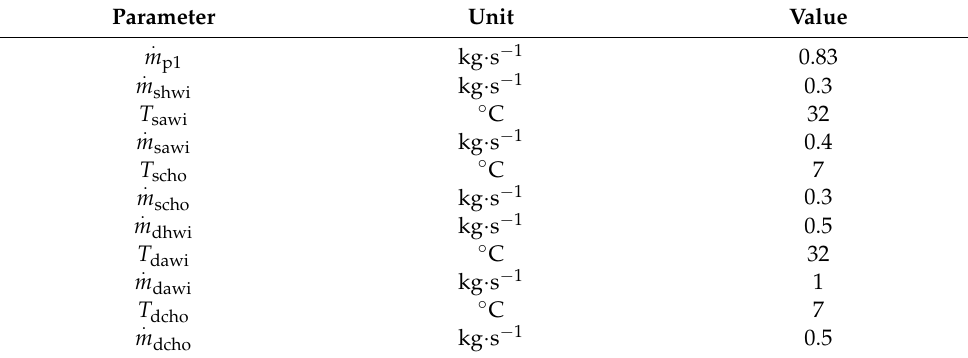
Table 3. Values for operating parameters of the